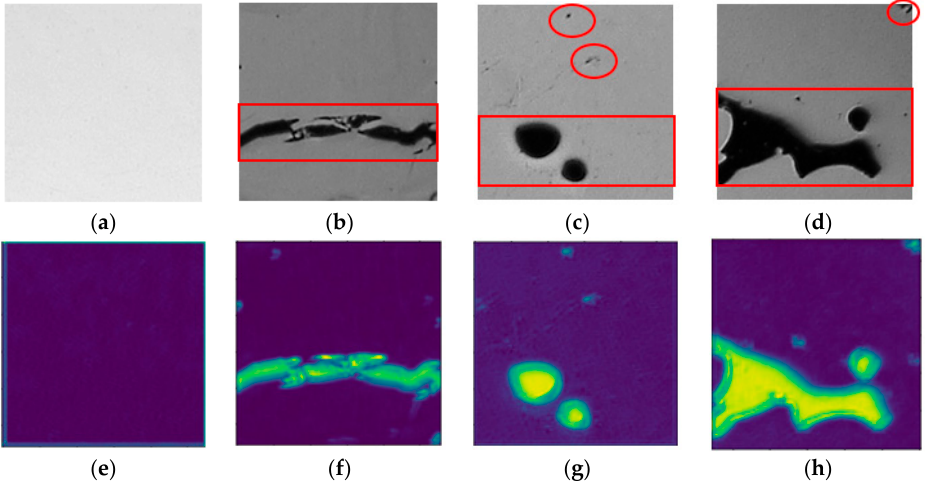
Figure 8. ( a – d ) Additive manufacturing build metal parts images, ( e – h ) attention maps corresponding to ( a – d ).